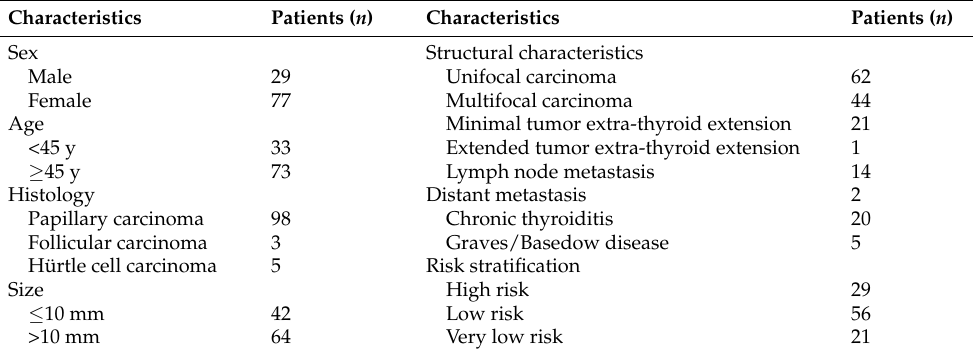
Table 1. Clinical and demographic characteristics of 106 patients with differentiated thyroid carci- noma (DTC) at the